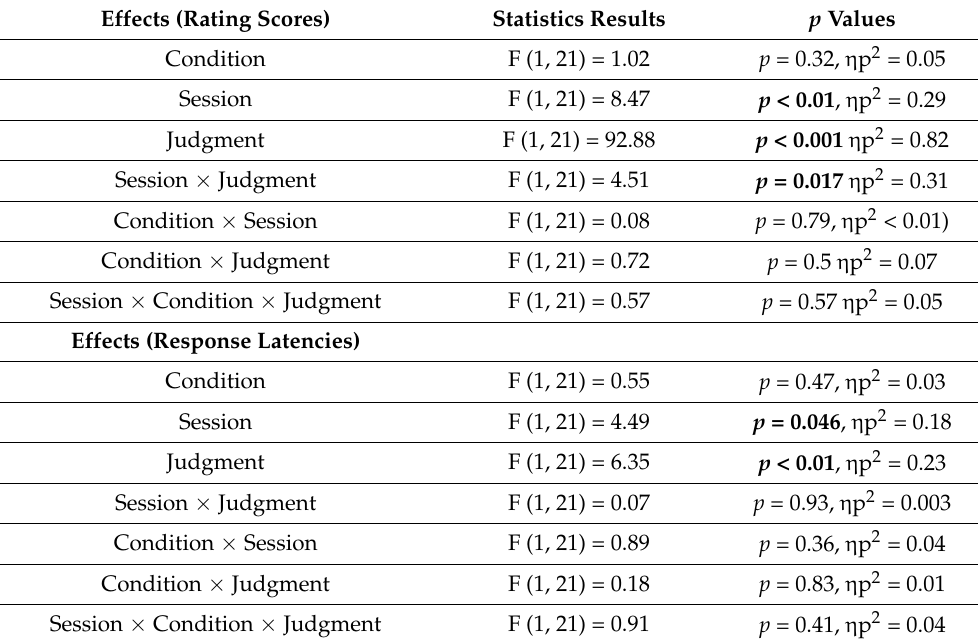
Figure 6. Participants’ mean rating percentage scores pre- and post- tDCS, both for sham and real conditions. Error bars represent ± 1 SEM. * represents significant differences. Table 2. Main statistic results of Experiment #2. Significant p values are reported in